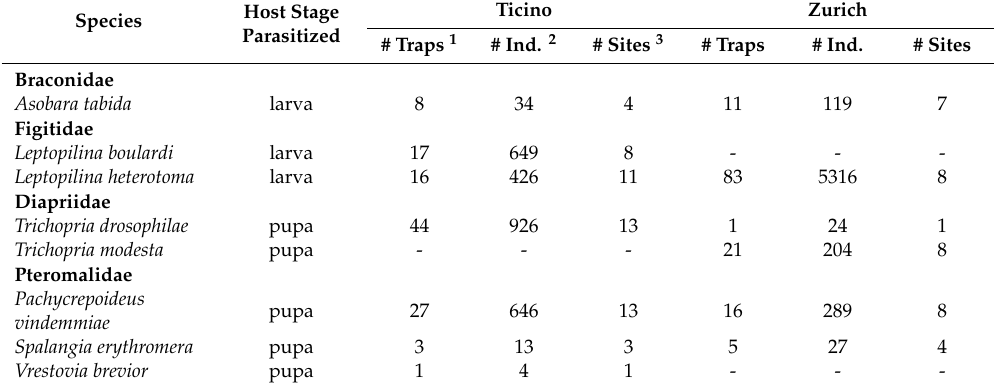
Table 3. Parasitoid species emerged from Delta-traps baited with four Drosophilidae species ( Drosophila hydei , D. immigrans , D. melanogaster , and D. subobscura ) in Ticino and Zurich in